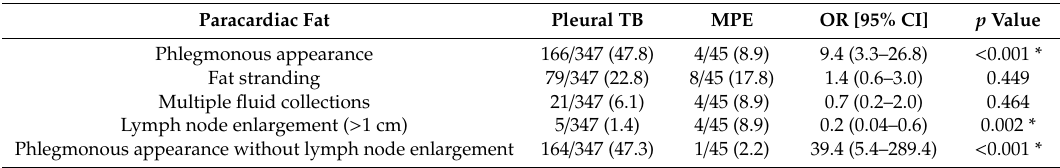
Table 3. Prevalence of CT findings in the ipsilateral paracardiac fat in patients with pleural TB and patients with MPE, lacking typical CT features of MPE (i.e., pleural nodular thickening > 1 cm).